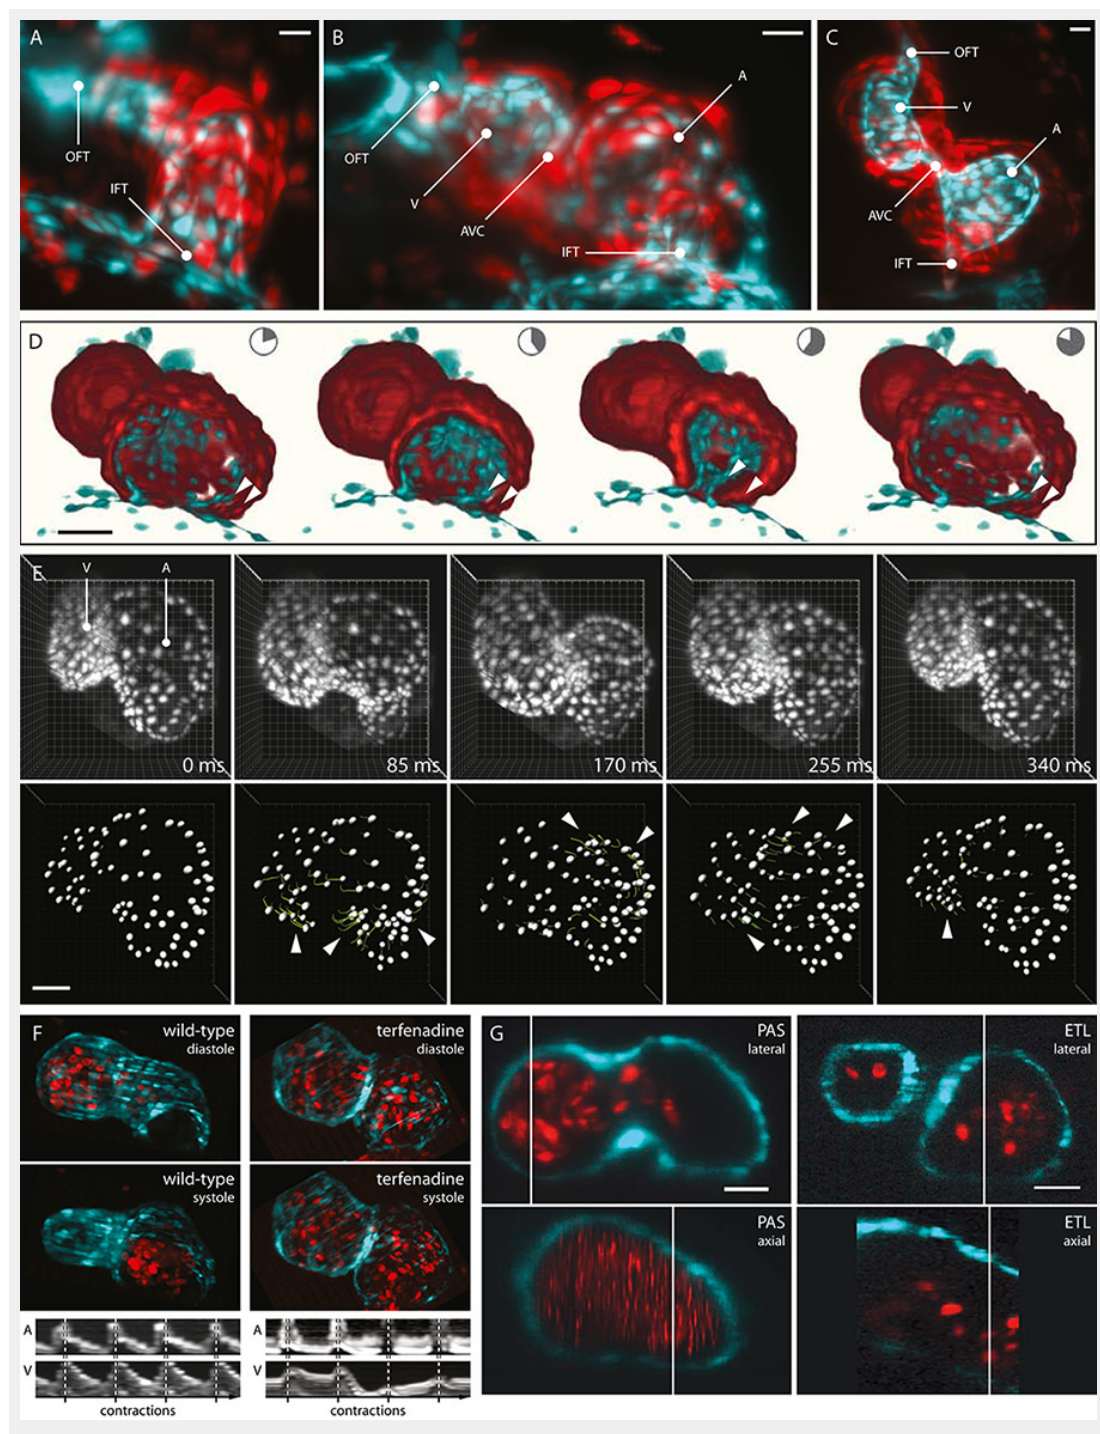
3D recordings of the embryonic zebrafish heart. A–C: Maximum intensity projections of image stacks recorded from silent hearts of 1–3 dpf transgenic Tg(kdrl:eGFP,myl7:dsRed, gata1a:dsRed) zebrafish. Inflow tract (IFT), atrium (A), atrioventricular canal (AVC), ventricle (V), outflow tract (OFT). Scale bar: 20 µm. D: 3D reconstruction of the beating heart of a 2 dpf zebrafish embryo. Cut open to reveal inflow tract and impact of cardiac jelly on pumping efficiency (arrow heads). E: 3D cell tracking in a beating zebrafish heart. 3D-projections of 2 dpf Tg(myl7:GCaMP5G- Arch(D95N), myl7:H2A-mCherry) zebrafish hearts. Postacquisition synchronisation, tracking based on segmentation of H2A-mCherry channel. Segmented cardiomyocytes with partial tracks (dragon tails, colour-coded for velocity). Areas of fastest contraction highlighted (arrow heads). F: Wild-type and arrhythmic hearts of 2 dpf transgenic Tg(myl7:GFP, GATA1:dsRed) zebrafish. Maximum intensity projections of rapid volume scanning image data. Arrhythmia induced by treatment with terfenadine. Kymographs of atrial and ventricular contractions. Ventricular contractions are absent in several cycles of the terfenadine-treated hearts. G: Comparison of 3D image data generated with postacquisition synchronisation (PAS) and rapid volume scanning (ETL). Hearts of 2 dpf of transgenic Tg(myl7:GFP, GATA1:dsRed) zebrafish. 3D blood cells are only visible in ETL data. Scale bar: 20